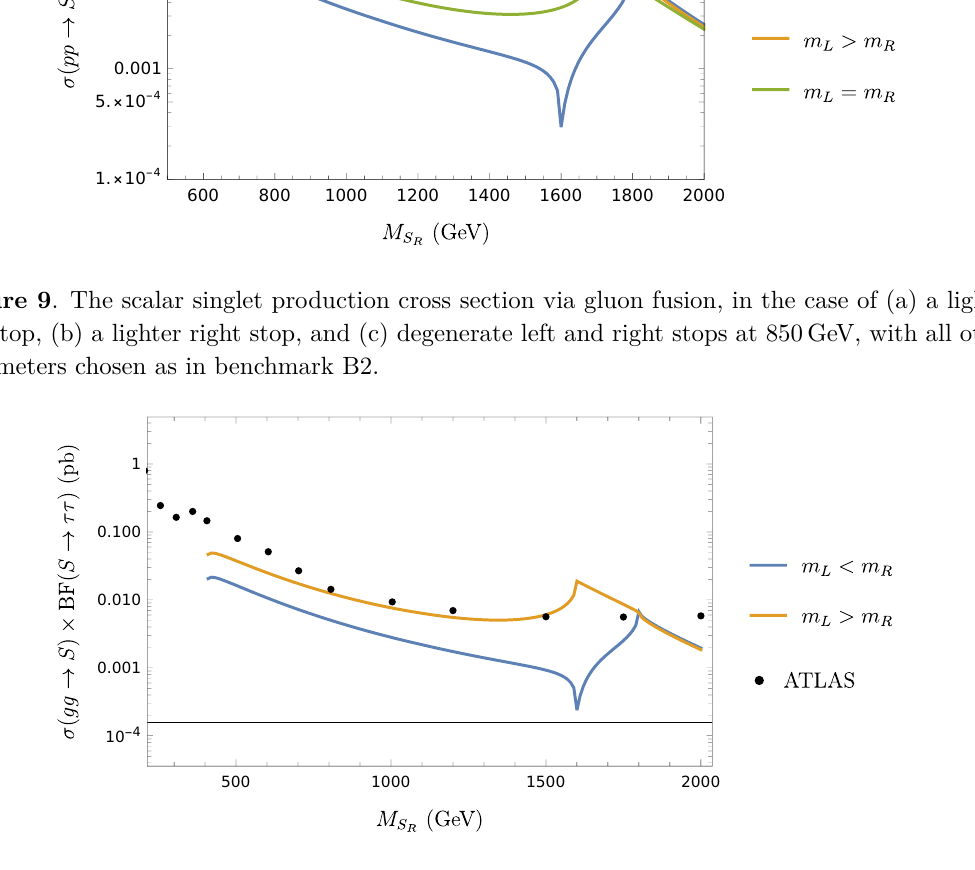
Figure 10 . Resonant tau pair production in benchmark B2, assuming a 100% branching ratio of the stau to tau plus missing energy. In black is the exclusion bound from